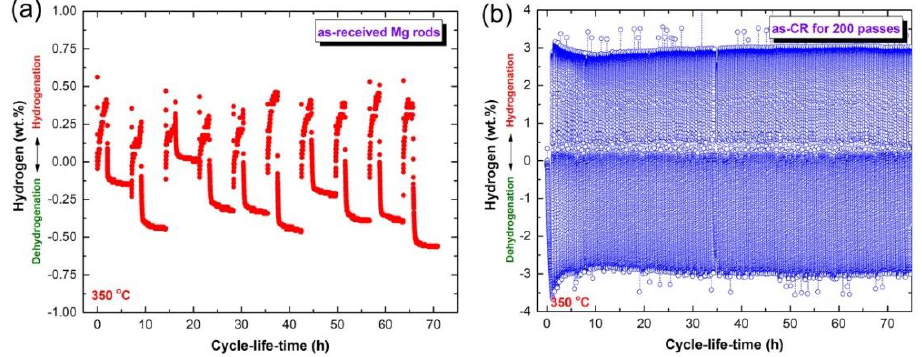
Figure 8. Cycle-life-time (CLT) examined under 10 bar (hydrogenation)/400 mbar (dehydrogena-